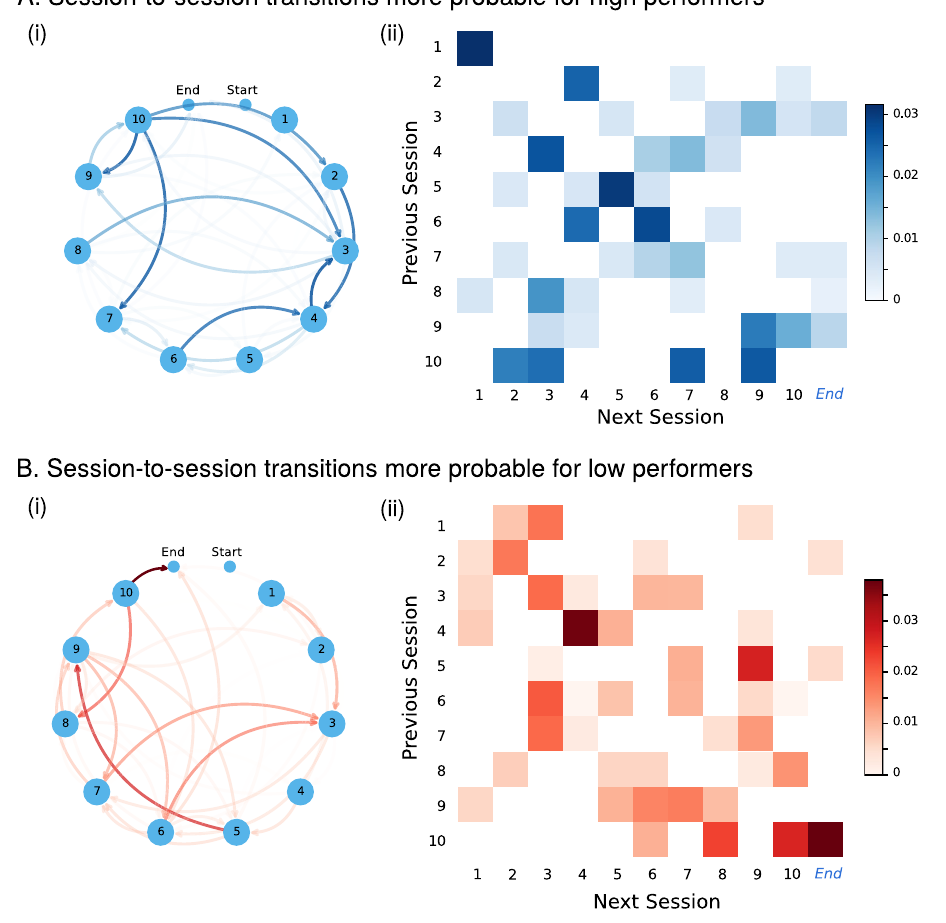
Figure 6. The transition probability between weekly sessions is calculated separately for the top 25% performers and the bottom 25% performers and the difference between the probabilities in the two groups is calculated. ( A ) The session-to-session transitions that are more probable for high performance learners (i) mapped onto a network structure and (ii) visualized as a transition matrix heatmap. ( B ) The session-to-session transitions that are more probable for low performance learners (i) mapped onto a network structure and (ii) visualised as a transition matrix